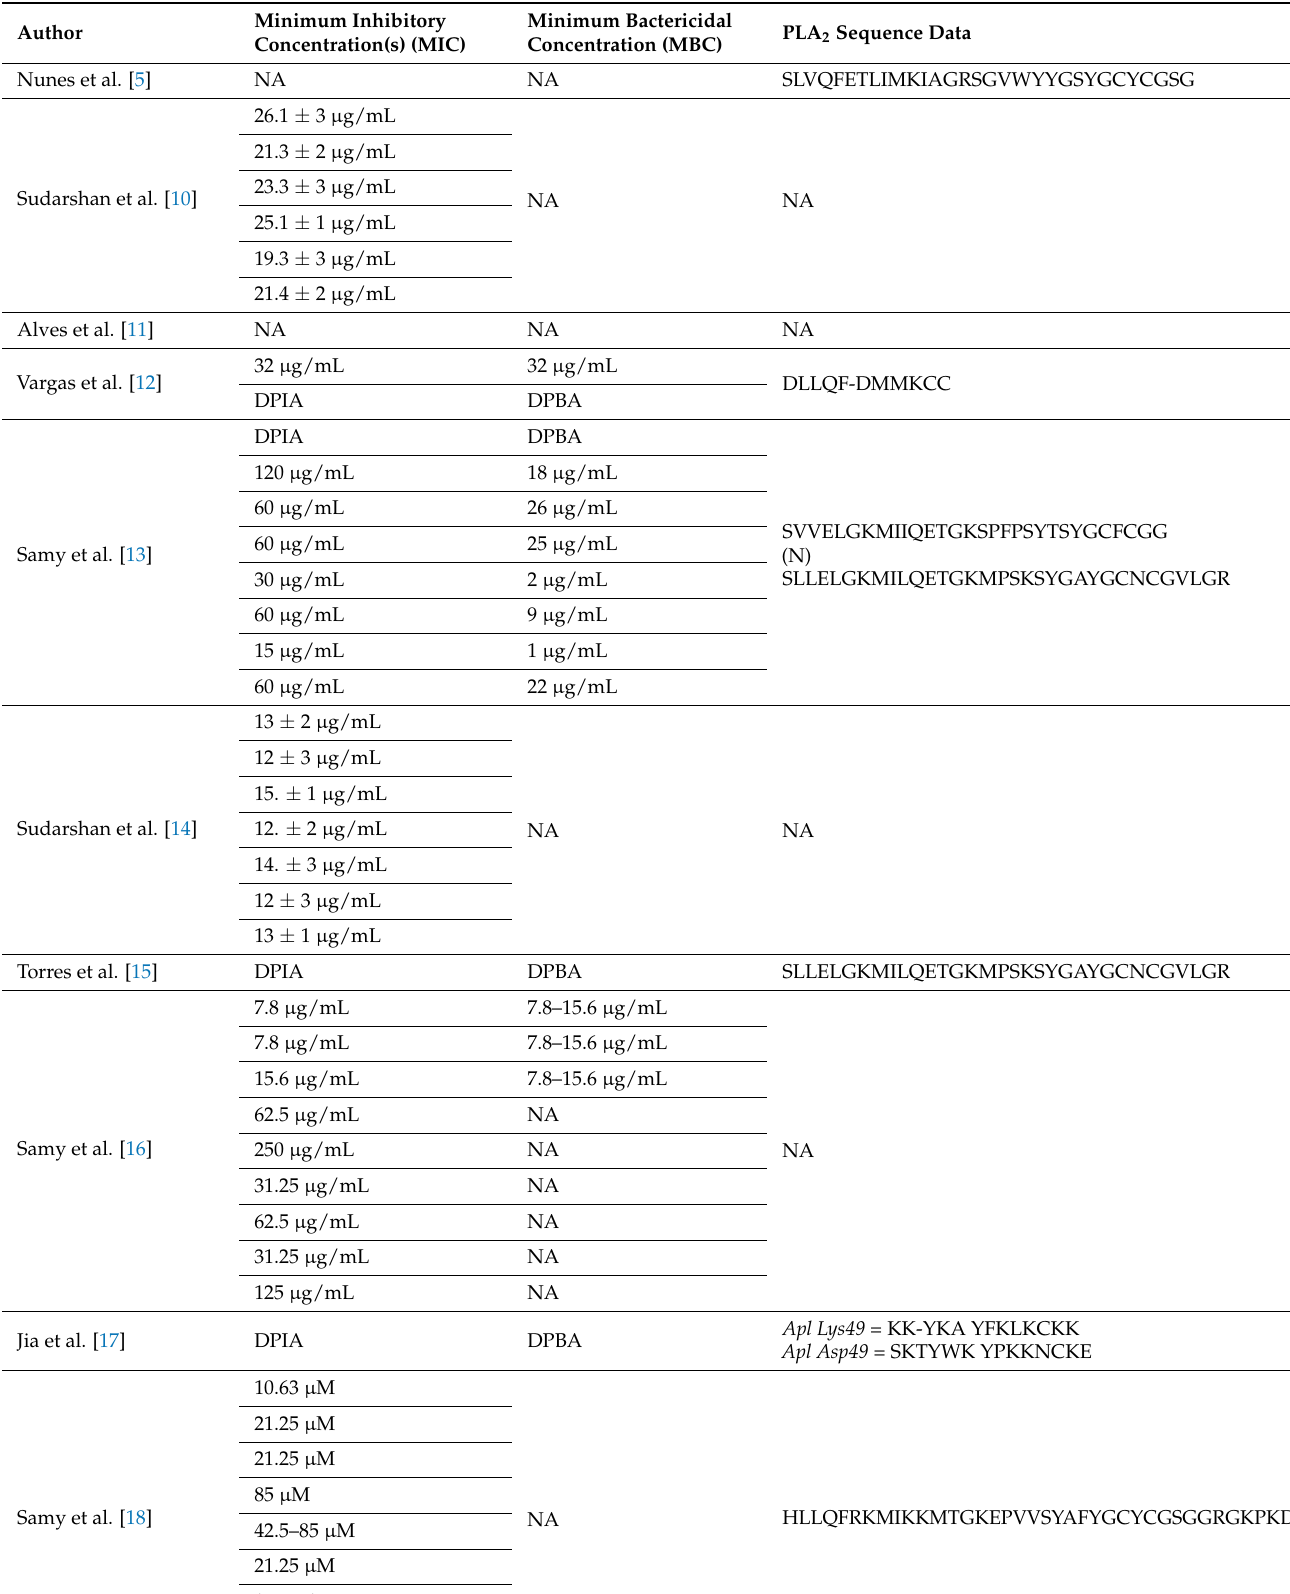
Table 2. Summary table for MIC, MBC, and sequence data extracted from the included